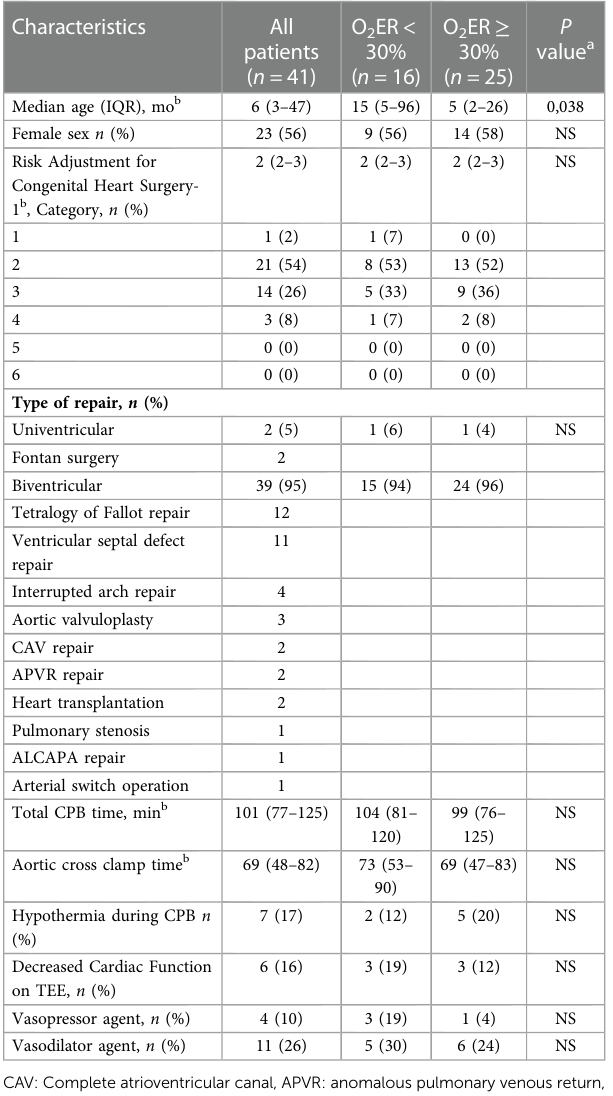
TABLE 1 Patient demographics and baseline characteristics by O 2 ER value. Characteristics